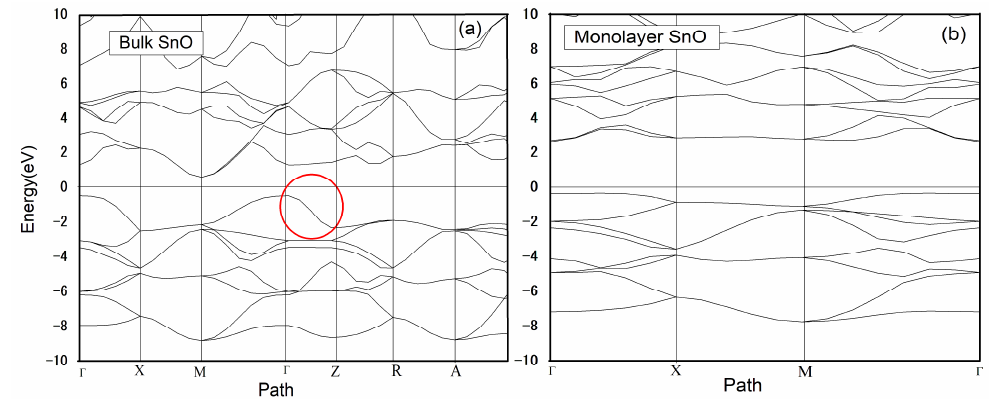
Figure 2. ADF calculated Band Structure calculated for ( a ) Bulk SnO and ( b ) Monolayer SnO. The Fermi level is adjusted at 0 eV.